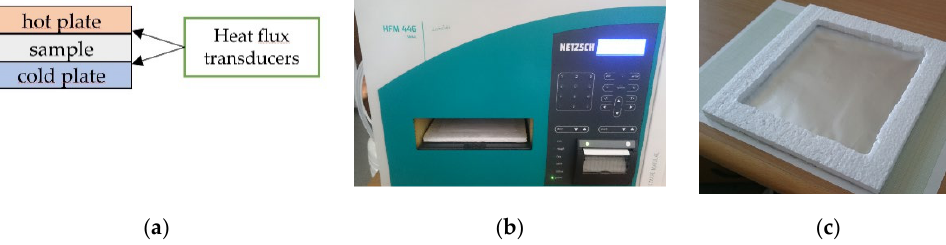
Figure 10. ( a ) HFM measuring principle; ( b ) measurement device; ( c ) sample holder frame.